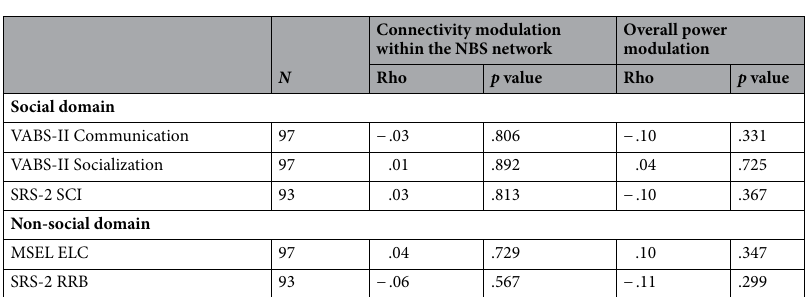
Figure 3. Theta connectivity modulations by social context. ( a ) Density and boxplots for global connectivity for the social (blue) and non-social (orange) condition in the NFH group (top) and FH group (bottom). Each dot represents 1 infant. ( b ) Network of edges and nodes showing elevated connectivity during the social versus non- social condition. ( c ) Density and boxplots for connectivity within the social network for the social (blue) and non-social (orange) condition in the NFH group (top) and FH group (bottom). Each dot represents 1 infant.